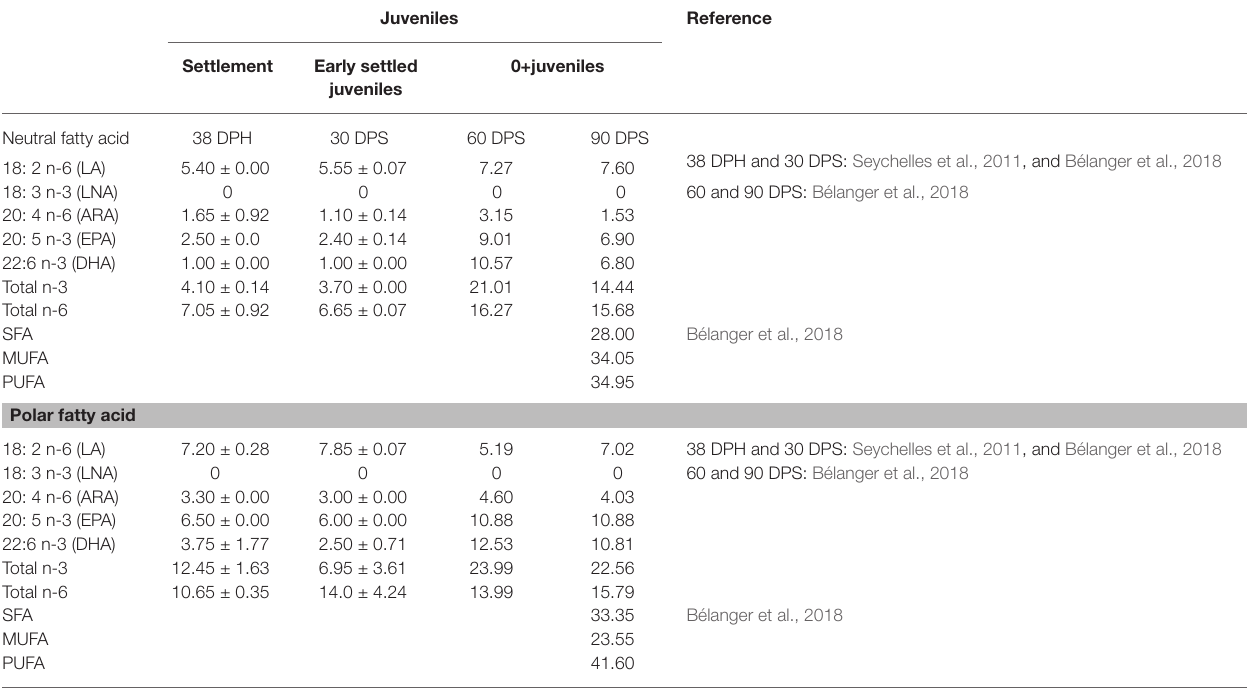
TABLE 5 | Relative percentages of neutral and polar fatty acids in winter flounder ( P. americanus ) juveniles at the beginning of settlement (38 DPH), 30 DPS, and at the 0+ juvenile stage (60 and 90